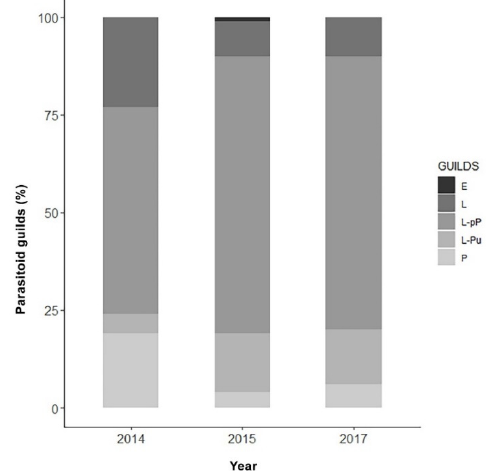
Figure 6. Parasitoid guilds (%) obtained across the three-year sampling in Tuscany, Central Italy, on the base of the host stage attacked. E: parasitoids attacking eggs (excluding Trichogramma spp.); L: larval parasitoids; L-pP: larvo-prepupal parasitoids; L-Pu: larvo-pupal parasitoids; P: pupal par- asitoids.